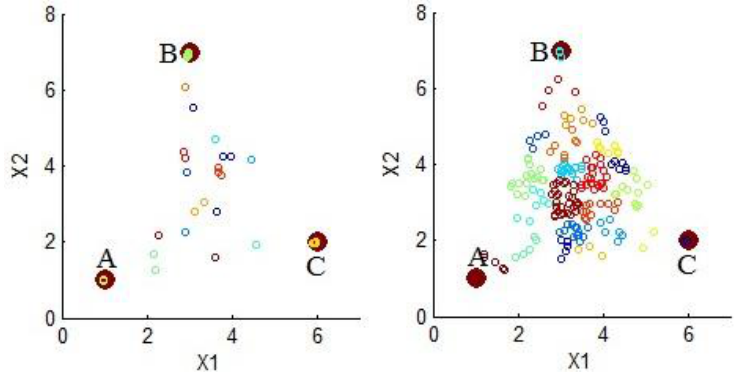
Figure 4. ( Left ) A set of points with low spectral mixing, most of the points are close to the endmembers; ( Right ) A set of points with high spectral mixing, most of the points are not close to the endmembers. In both cases, colors represent how the clustering process group the